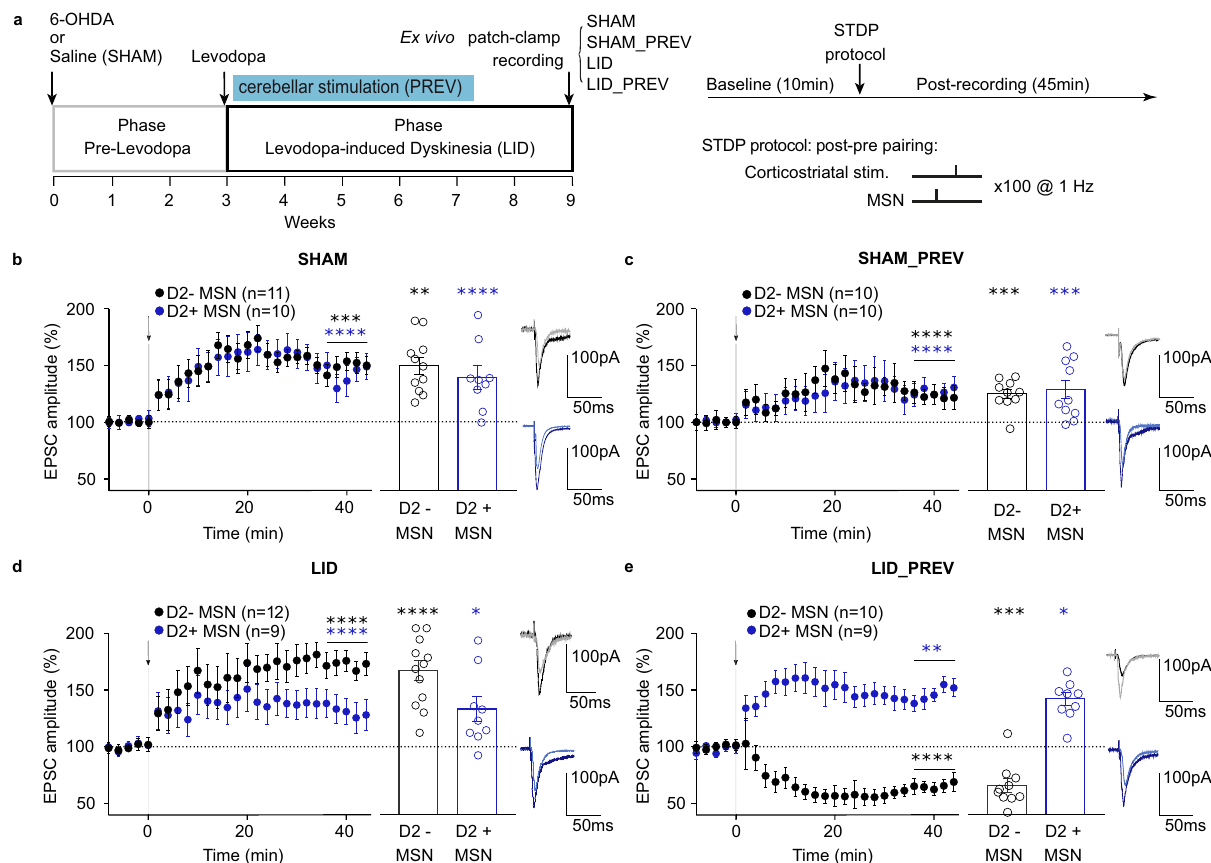
Fig. 6 Spike-timing dependent plasticity produces LTD instead of LTP in D1-expressing neurons following Purkinje cell stimulation. a Left: Experimental timeline. SHAM mice: 6 weeks of levodopa treatment. Preventive SHAM mice (SHAM_PREV): 6 weeks of levodopa treatment + 4 weeks of cerebellar stimulation. Dyskinetic mice (LID): 6 weeks of levodopa treatment. Preventive mice (LID_PREV): 6 weeks of levodopa treatment + 4 weeks of cerebellar stimulation. Ex vivo experiments were realized on mice subjected to 4 conditions, i.e. SHAM, SHAM_PREV, LID and LID_PREV. Right : STDP pairings: A single spike evoked in the recorded MSN (post) was paired with a single cortical stimulation (pre); pairings were repeated 100 times at 1 Hz. b – e Averaged time courses of corticostriatal STDP in D1-MSNs and D2-MSNs induced by 100 post pre pairings. b In SHAM, LTP induced by 100 post – pre pairings in D1- MSNs and D2-MSNs ( n = 21). c In SHAM_PREV, LTP induced by 100 post – pre pairings in D1-MSNs and D2-MSNs ( n = 20). d In LID, LTP induced by